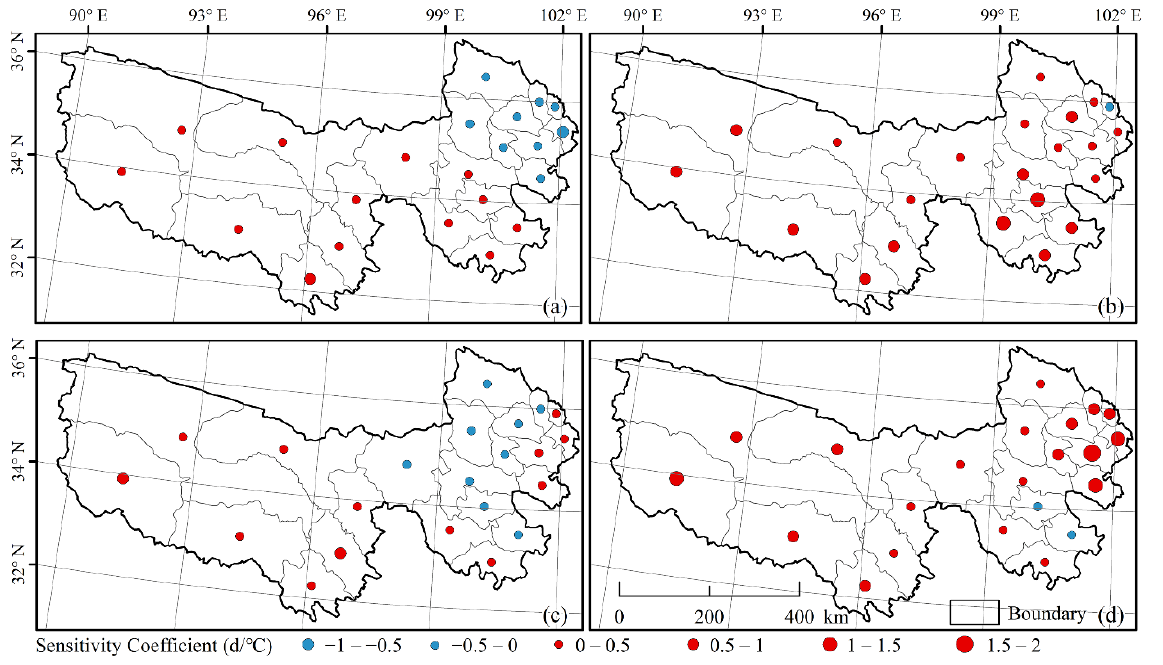
Figure 15. Spatial distribution of the sensitivity coefficients between the EOS of the vegetation and air temperature in August ( a ), September ( b ), October ( c ) and August – October ( d ) in the Three-River headwaters region.